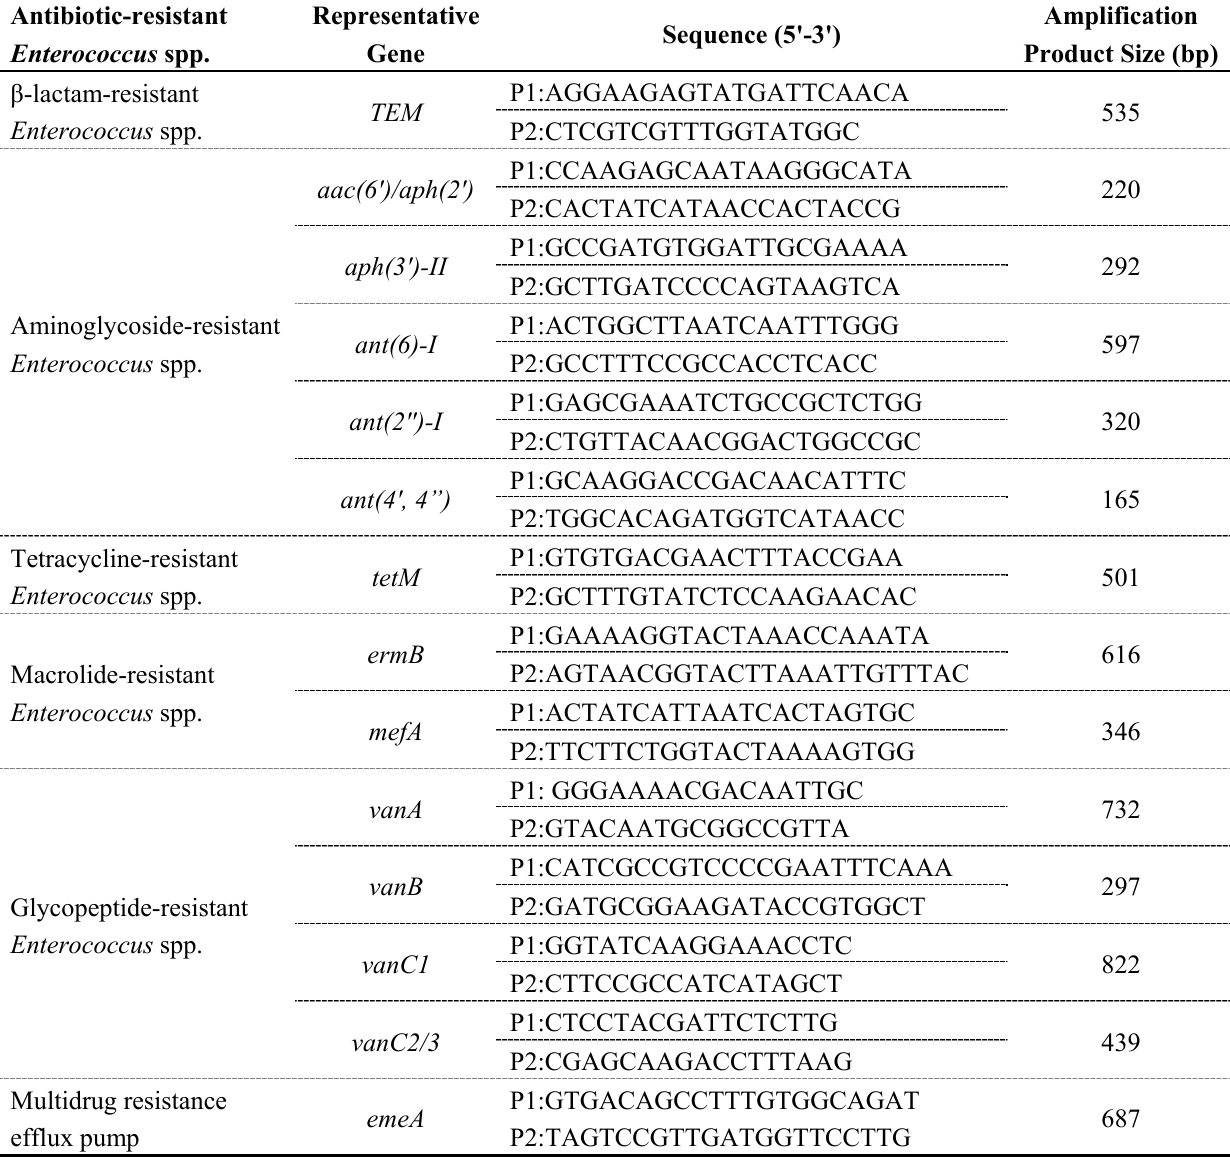
Table 2. Sequences of the primers for amplification of antibiotics-resistant genes in Enterococcus spp. Antibiotic-resistant Enterococcus spp. β -lactam-resistant Enterococcus spp.